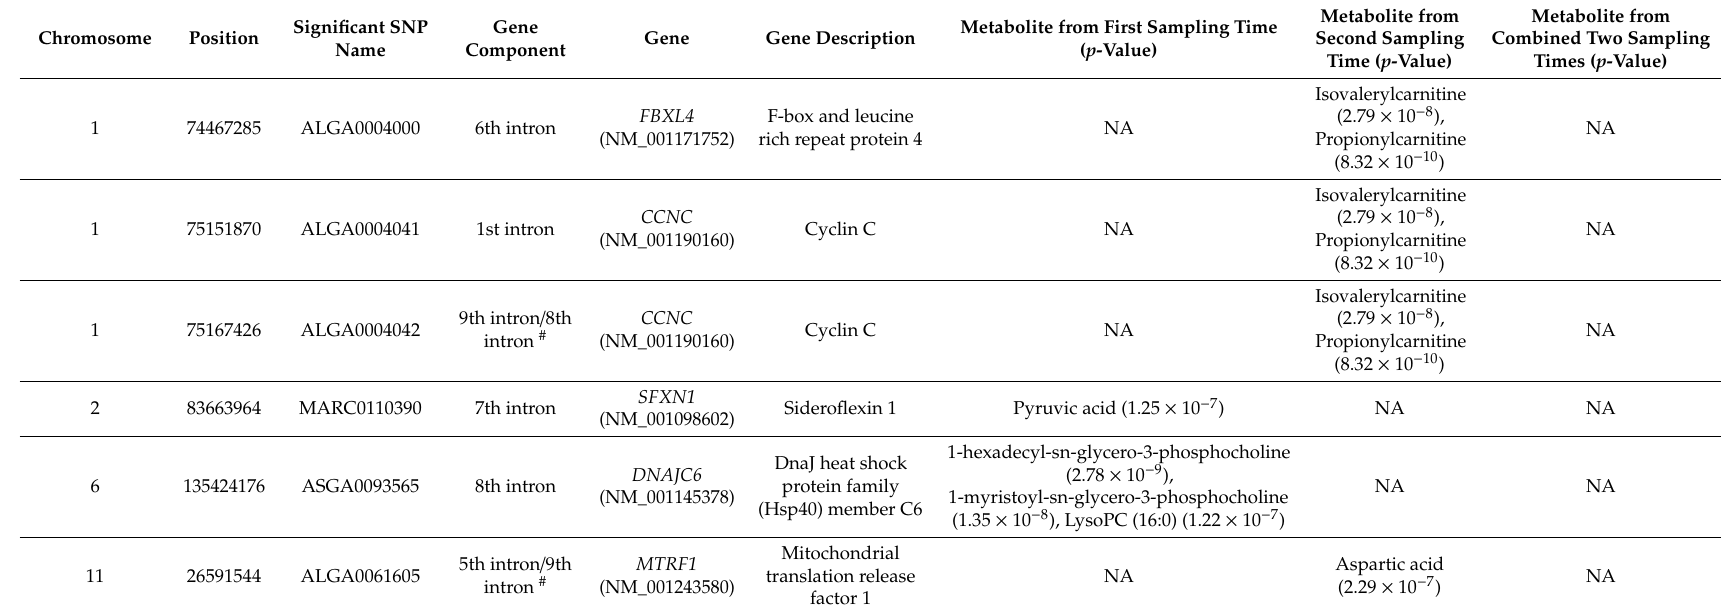
Table 3. Gene component annotation for genome-wide significant